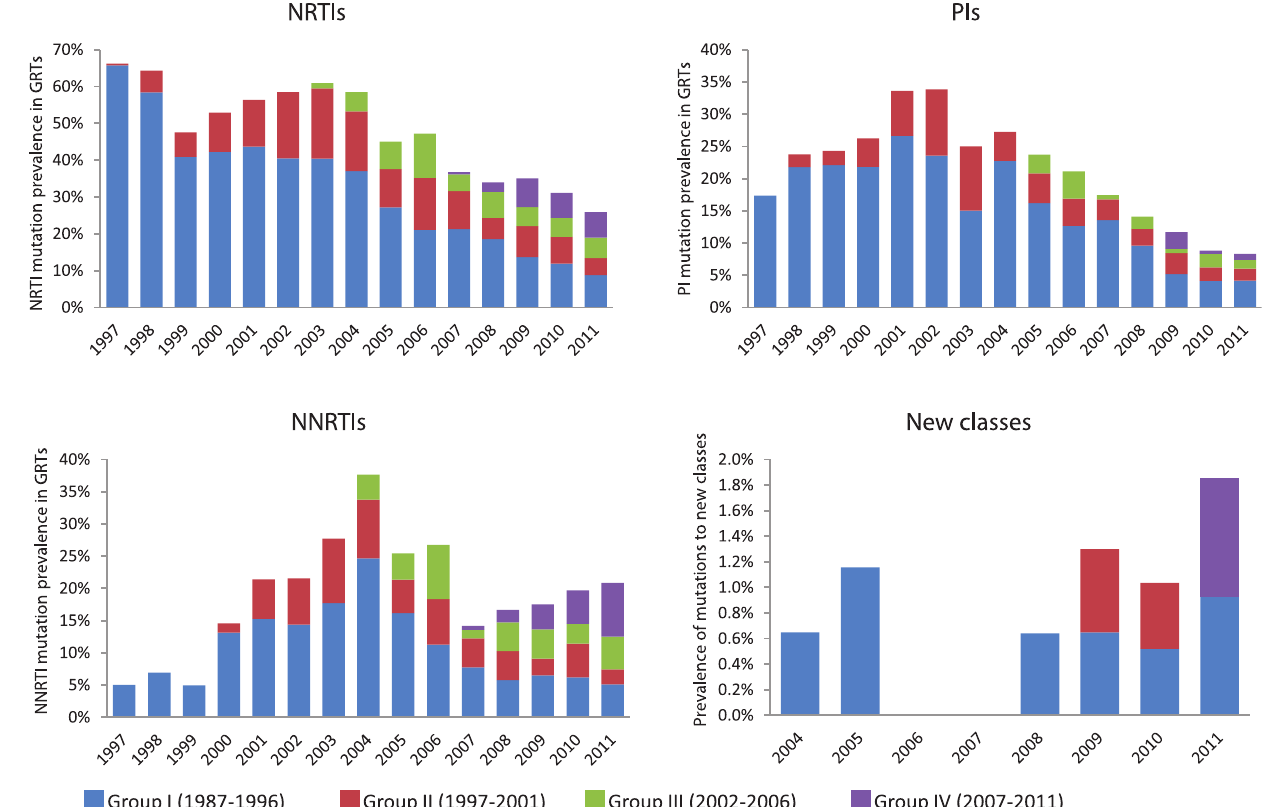
Figure 4. Resistance by year of first ART. These graphs show the level of resistance in each given year by the four groups, I–IV. This aims to show the composition of resistance over time, where patients with early exposure to ART (groups I and II) constitute the vast majority of resistance cases. Even in recent years, most resistance is found among these patients although they comprise a relatively small portion of the total number of patients on ART (group I patients corresponded to just 18% of patients on ART in 2011). Important differences can be noted between drug classes, where group IV patients contribute to a substantial proportion of recent NNRTI mutations while hardly any PI mutations have been found in this group.